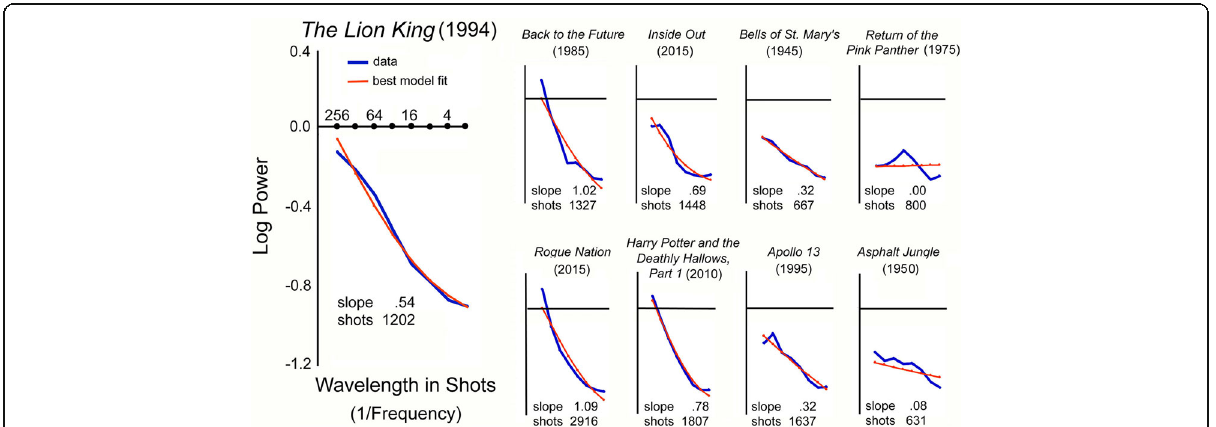
Fig. 3 Power spectra for the data (in blue ) of and model fits (in red ) to the shot-duration fluctuations of nine movies. These reflect a power analysis on the normalized shot vectors for each movie. Notice three trends: steeper-sloped movies tend to be more recent, more recent movies tend to have more shots, and model fits tend to be better for movies with more shots. These parallel trends form the focus of Studies 1 –